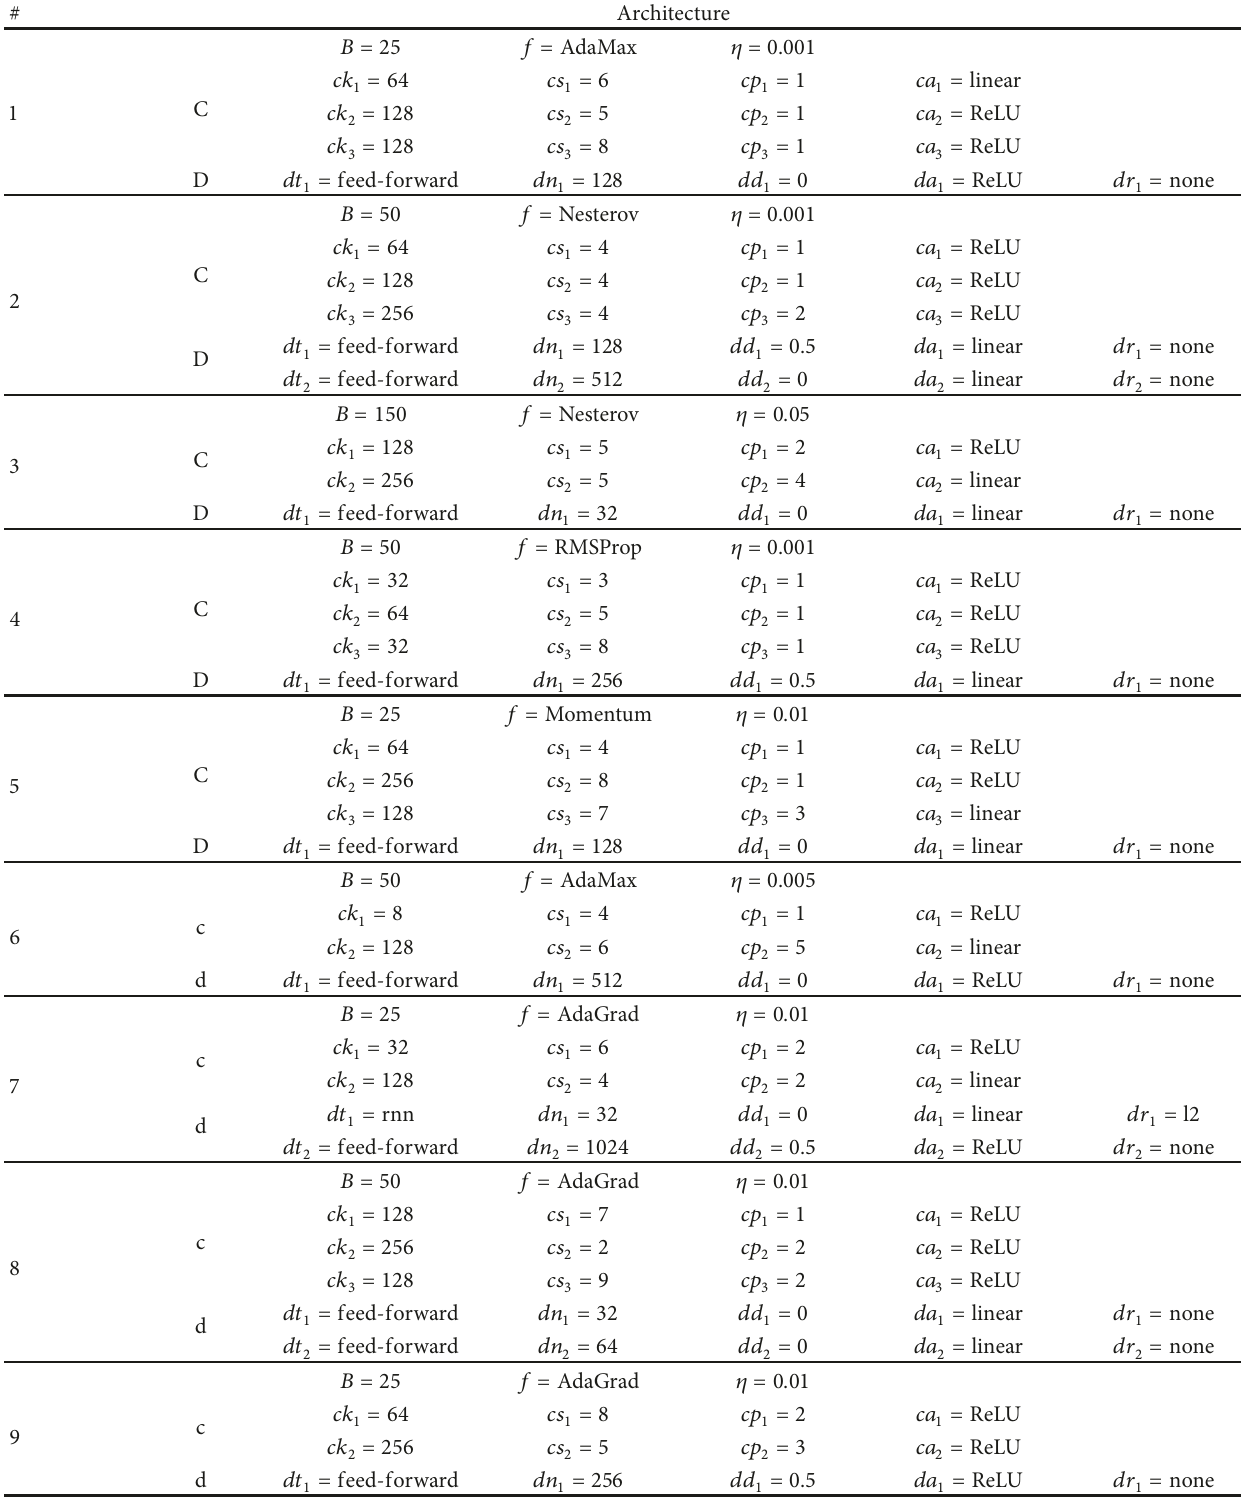
Table 1: Top 10 topologies in the hall-of-fame for the GA in the MNIST dataset. c (convolutional), d (dense), 𝑐𝑘 𝑖 (kernels in the 𝑖 -th conv. layer), 𝑐𝑠 𝑖 (kernel size in the 𝑖 -th conv. layer), 𝑐𝑝 𝑖 (pooling size after the 𝑖 -th conv. layer–1 means no pooling), 𝑐𝑎 𝑖 (activation in the 𝑖 -th